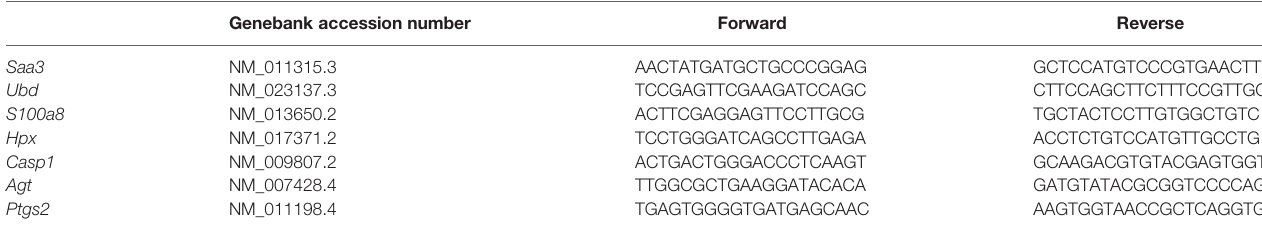
TABLE 1 | Forward and revers primers used in quantitative